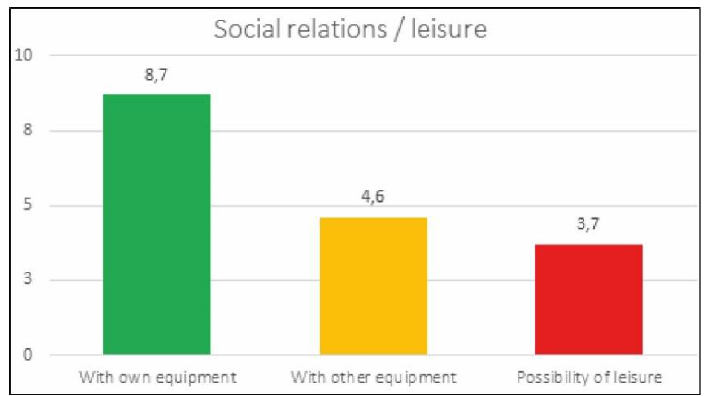
Figure 14. Night rest/Toilets/Food.